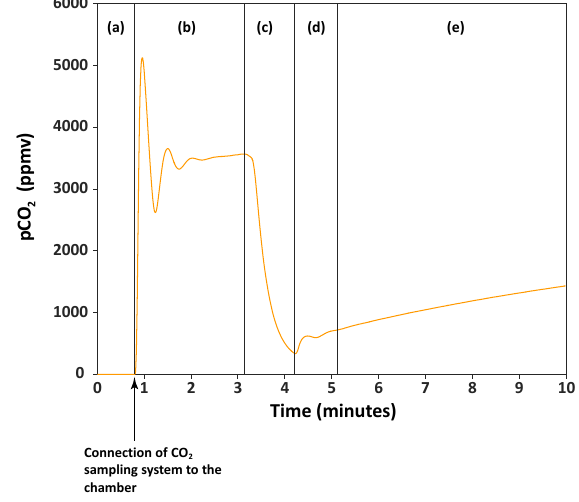
Figure 2. An example of the monitoring of the CO 2 accumulating in a chamber. The orange curve is the partial pressure of CO 2 ( p CO 2 , in parts per million volume) through time in chamber H6 on 27 March 2017. (a) The CO 2 sampling–monitoring system is not con- nected to the chamber. Atmospheric CO 2 has been removed from the system ( p CO 2 = 0ppm) using the CO 2 scrub cartridge. (b) The closed-loop monitoring system has been connected to the chamber. p CO 2 increases to reach a maximum value of ∼ 5100ppm, then Figure 1. (a) Schematic diagram of the closed-loop monitoring– drops and equilibrates to ∼ 3500ppm. This pattern reflects the in- sampling system connected to the natural weathering chamber. Gas- crease in the total volume (by the volume of the CO 2 sampling– flow pathways are controlled by opening and closing the clips. Clips monitoring system) which decreases p CO 2 and requires some time removed from the bypass allow p CO 2 in the chamber to be moni- for the p CO 2 to equilibrate. We determined that when connected tored (IRGA stands for infrared gas analyzer), thus measuring CO 2 to the chamber, the maximum value of p CO 2 read is 0.94 the ac- flux and ensuring that enough CO 2 accumulated in the chamber for tual p CO 2 in the chamber. (c) The CO 2 in the chamber is lowered 14 C analysis. To remove CO 2 from the line before connecting to the (scrubbed with the CO 2 scrub, or trapped with the zeolite molecu- chamber, clips are moved from the CO 2 scrub (soda lime). When lar sieve) to near-atmospheric p CO 2 . (d) Residual CO 2 that in the connected to the chamber, the CO 2 scrub can be used to lower the chamber homogenized with the rest of the total volume “artificially” CO 2 concentration before flux measurement. To collect CO 2 for increasing p CO 2 quickly. (e) p CO 2 in chamber is monitored, re- isotope analyses, clips are removed from the zeolite molecular sieve flecting the flux of CO 2 from the rock surface to the cartridge. (b) Pictures showing the chamber design. Top picture is the chamber (H6), diameter 2.9cm, drilled in the rock on a cleared surface, with white PVC tubing inserted at the outlet. Bottom pic- ture shows the rubber stopper fitted in the PVC tubing. Two glass tubes go through the rubber stopper and are fitted with Tygon tub- ing, sealed with the red clips, and the exterior of the chamber is sealed with outdoor sealant. (c) View of the field site showing two chambers (top chamber is H6 and lower chamber is H4). The lower chamber is connected to the closed-loop system and is being moni- tored for flux measurement. The two large grey PVC tubes attached to the rock on the right of the chambers are cases in which zeolite molecular sieves are installed and left for months when connected to the chamber for passive CO 2 trapping.